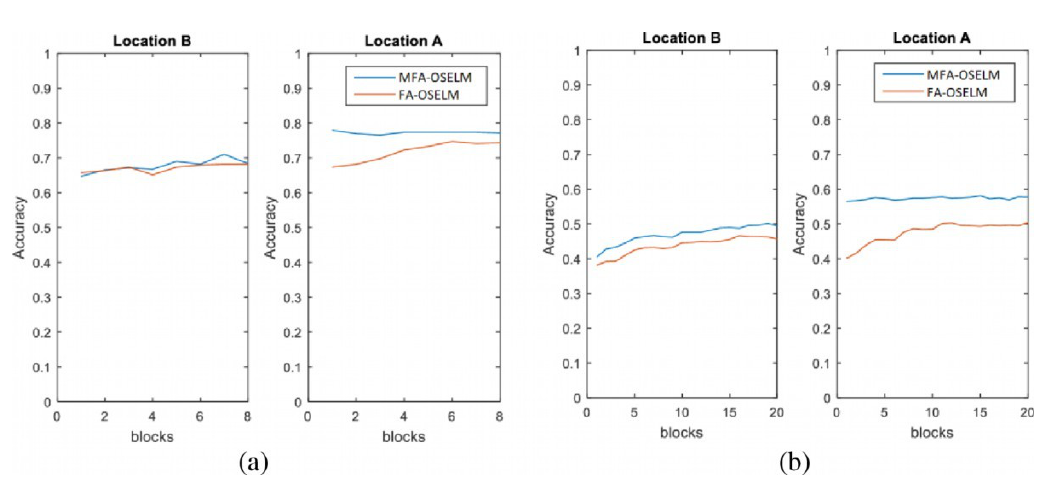
Figure 5. Scenario 1: The accuracy of the maximum feature adaptive online sequential extreme learning machine (MFA-OSELM) and the feature adaptive online sequential extreme learning machine (FA-OSELM) for ( a ) the TampereU dataset and ( b ) the UJIIndoorLoc dataset.